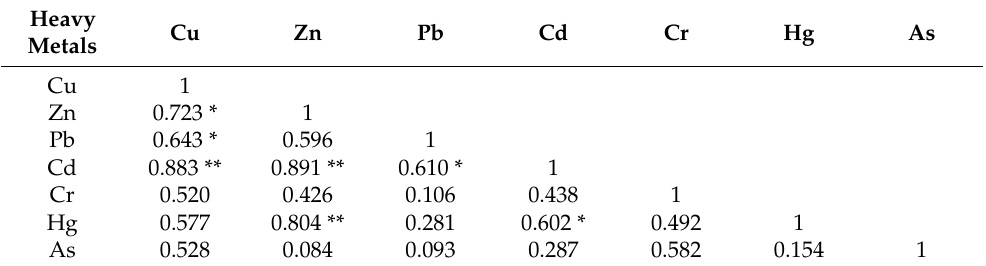
Table 4. Pearson’s correlation matrix of sediment heavy metals.